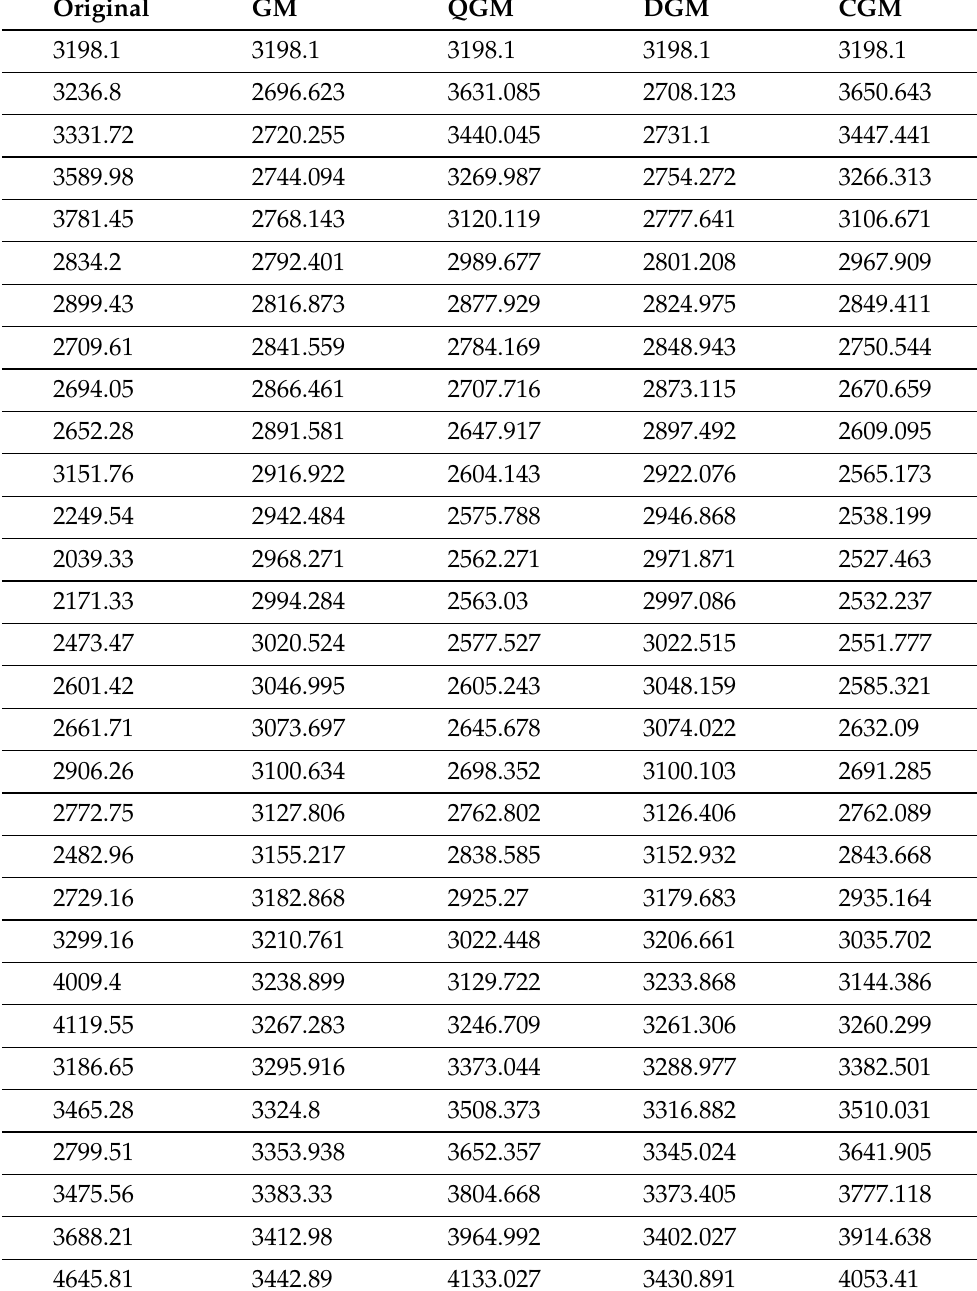
Table 2. Forecasted results of